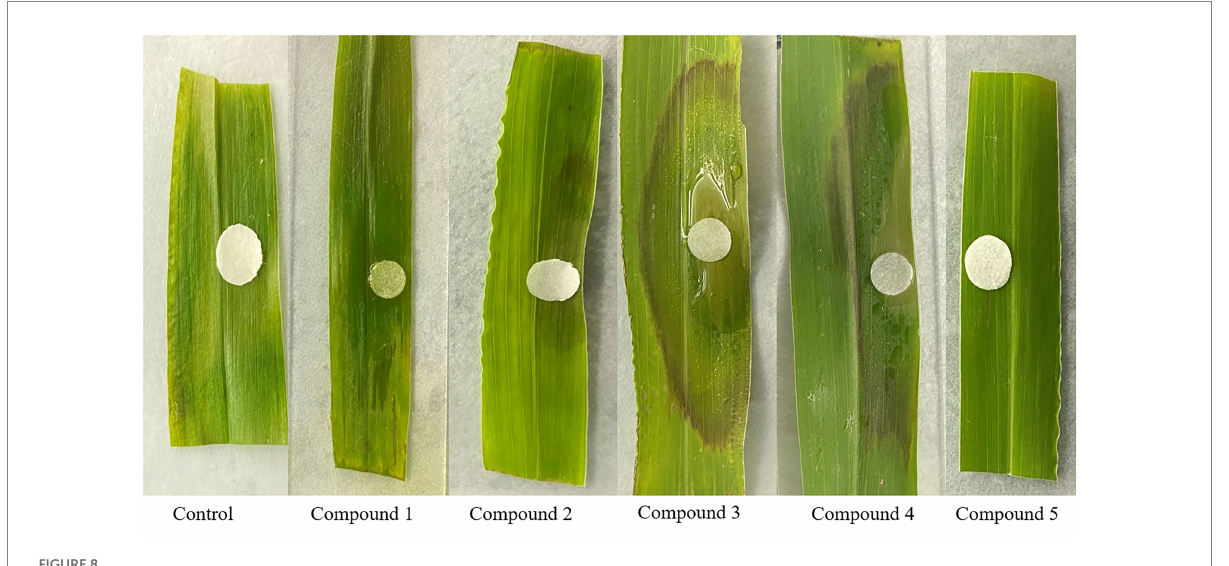
FIGURE 8 Phytotoxicities of 1 – 5 on the green foxtail leaves.